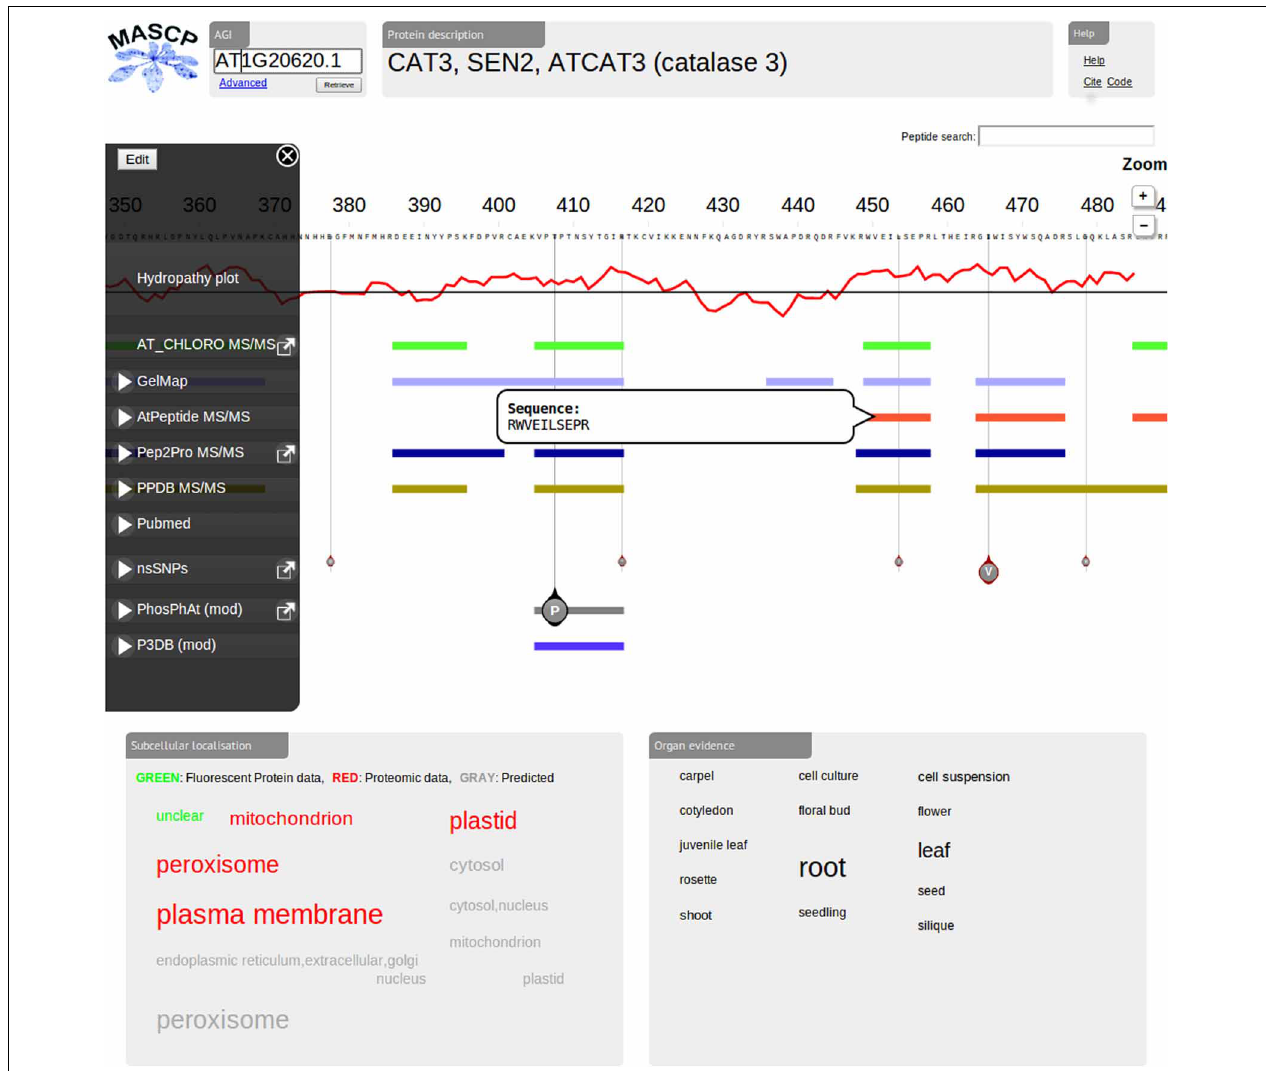
FIGURE 1 | Screenshot of the current release (version 2.0) of the MASCP Gator highlighting data for the AGI AT1G20620.1 (catalase 3). A number of new features can be observed including the peptide search function